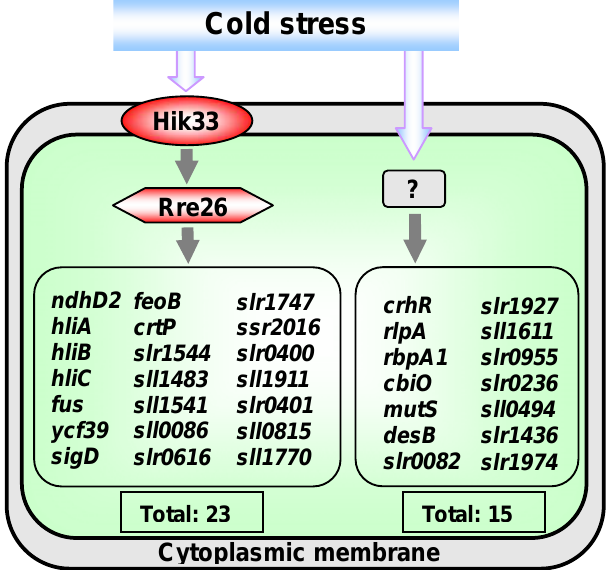
Figure 3. Schematic presentation of two-component system Hik33-Rre26 involved in the transduction of low-temperature stress. Primary signals are represented by open blue arrows. The sensory histidine kinase Hik33 supposedly perceives the temperature-induced rigidification in the cytoplasmic membrane. It tranduces the phosphoryl group to the response regulator Rre26, which itself might bind to promoter region of the genes to induce their transcription. Uncharacterized mechanisms are represented by question marks. Genes with induction factors (ratios of transcript levels of stressed cells to those of non-stressed cells) higher than 3 : 1 are included in these scheme. Adopted from [28]. Published with permission of Horizon Scientific Press / Caister Academic